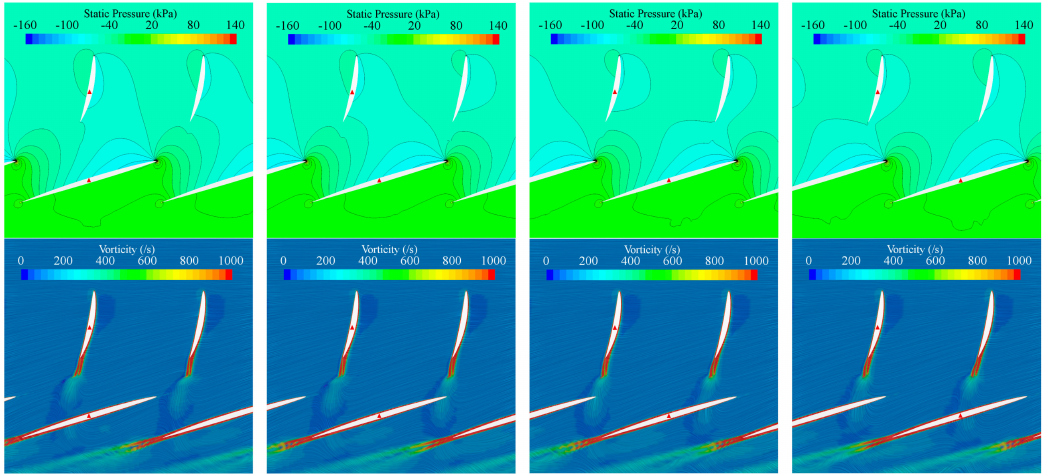
Figure 16. The pressure ( top row ) and vorticity ( bottom row ) around stator and rotor blade sections at 0.95 R tip . The rotor blade angle θ R = 0 ◦ , 10 ◦ , 20 ◦ , 30 ◦ (from left to right ). Q = 0.42 m 3